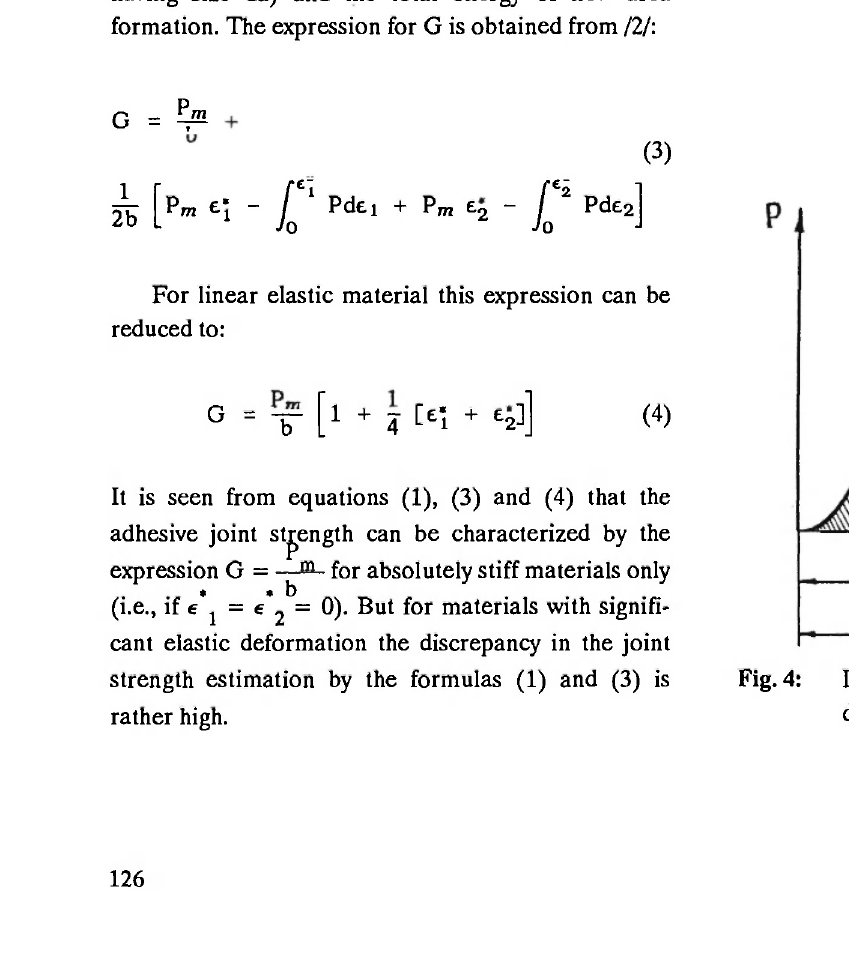
Fig. 4: Load-displacement diagram in the loading- delamination-unloading